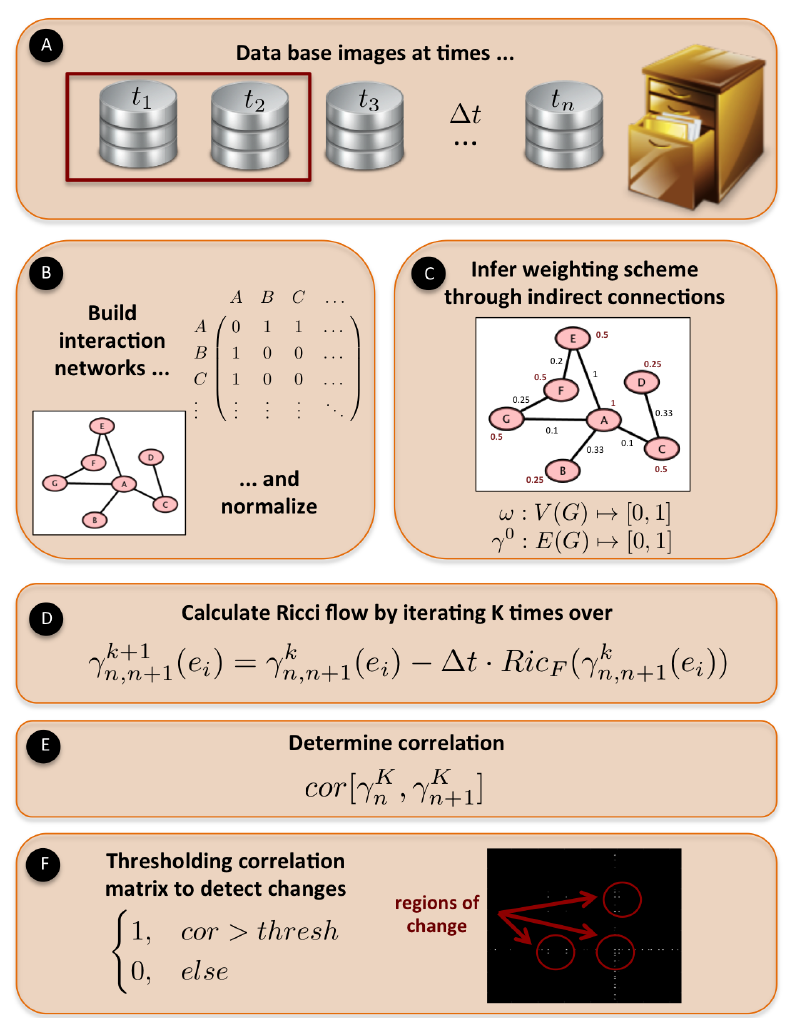
Schematic overview of the change detection workflow; ( A ) We consider a set of “snapshots” of a system or data base at discrete times ( t i ) i ∈ I with step size ∆ t ; ( B ) We infer unweighted (binary) networks from each snapshot that represent the structure of the underlying data. To simplify comparison, we normalize all networks; ( C ) By superimposing weighting schemes based on “indirect connections”, we extend the unweighted networks to weighted ones (see Section 1); ( D ) We calculate the Ricci flow for each time step ∆ t by iterating over a the given scheme; ( E ) For detection of changes, we compare the final (smoothed) weighting schemes after K iterations; ( F ) To identify regions that were subject to significant change, we threshold the correlation matrix obtained in ( E ). Light regions in the resulting map indicate such